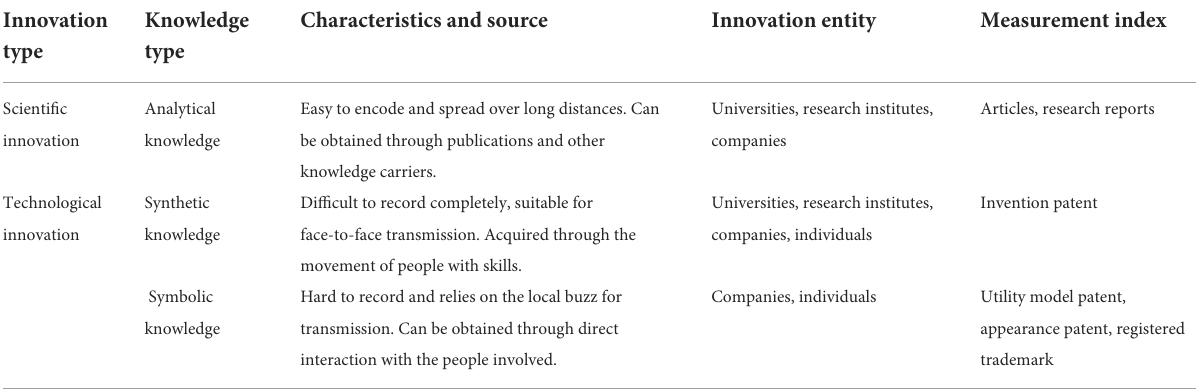
TABLE 1 Corresponding relationship between STI, knowledge type, and measurement